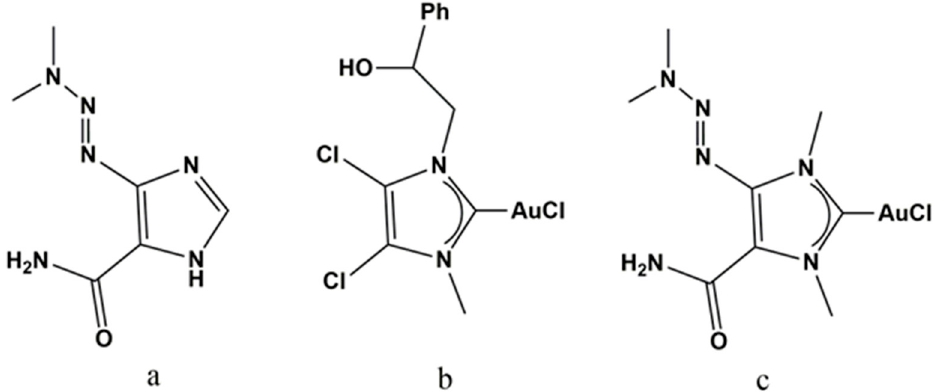
Figure 1. ( a ) Dacarbazine; ( b ) AuM1; ( c ) (NHC d )AuCl.